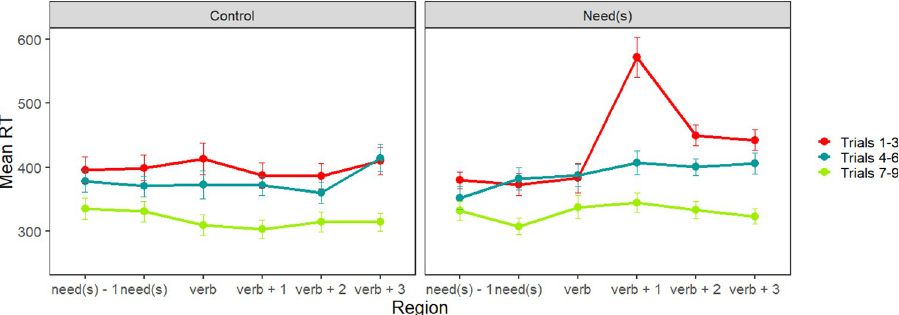
Fig 1. Experiment 1 exposure block. Mean reading times for critical sentence regions by trial number grouped by early (trials 1–3), middle (trials 4–6) and late (trials 7–9). Data from the Control group are presented on the left, while data from the Needs group are presented on the